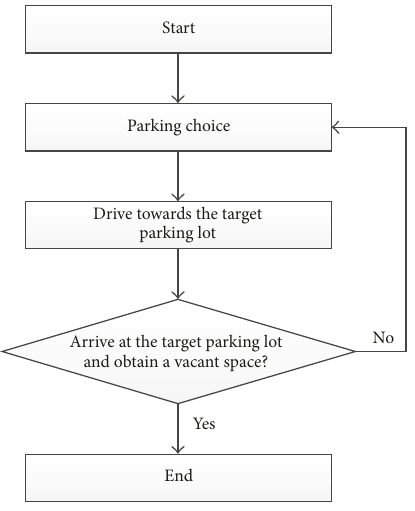
Figure 1: Process of cruising for vacant